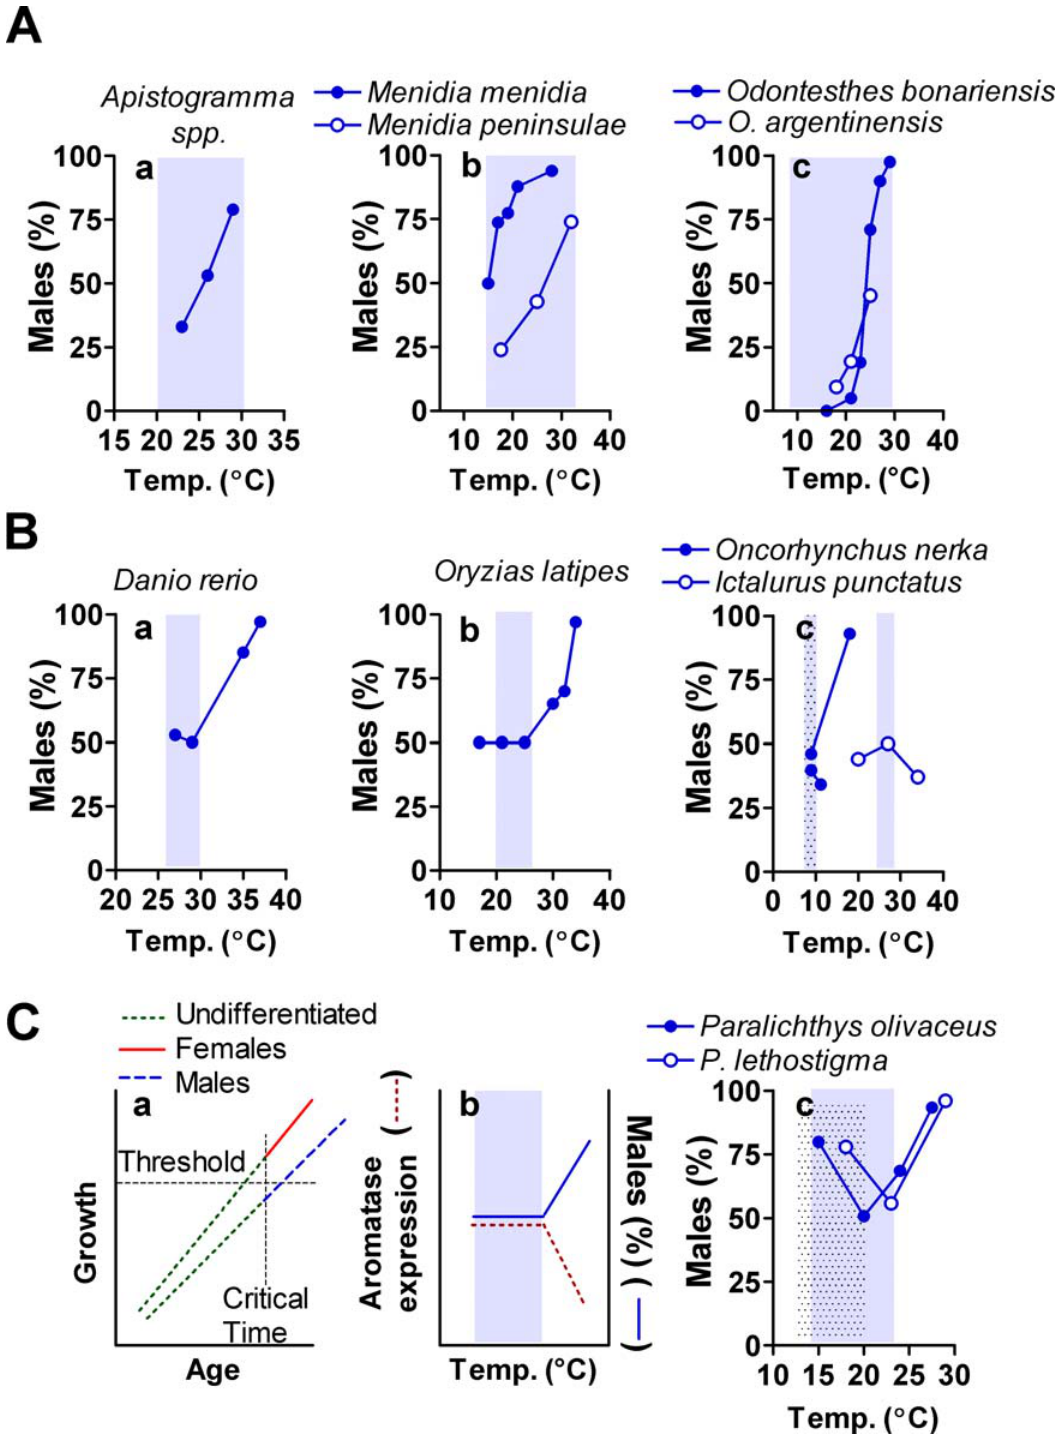
Figure 3. Patterns of sex ratio response to temperature in fish. A , Examples of authentic cases of TSD following pattern 1, more males with increasing temperatures. Sex ratio shifts occur within the range of temperature (shaded areas) normally experienced by fish in the wild. B , Examples of false cases of TSD. Sex ratio shifts only occur at extreme temperatures, and thus represent thermal effects on GSD (a, b). Formerly proposed pattern 2 (c), fewer males at high temperature, is not supported by re-analysis of data (see also Supplementary Table 1). C , Formerly proposed pattern 3, more males at extreme temperatures, can be explained from the combination of two effects unrelated to TSD: slow growing fish at low temperature differentiating as males (a), and the inhibition of aromatase at high temperature causing sex-reversal of genetic females (b). When combined, the two effects result in the observed pattern (c).